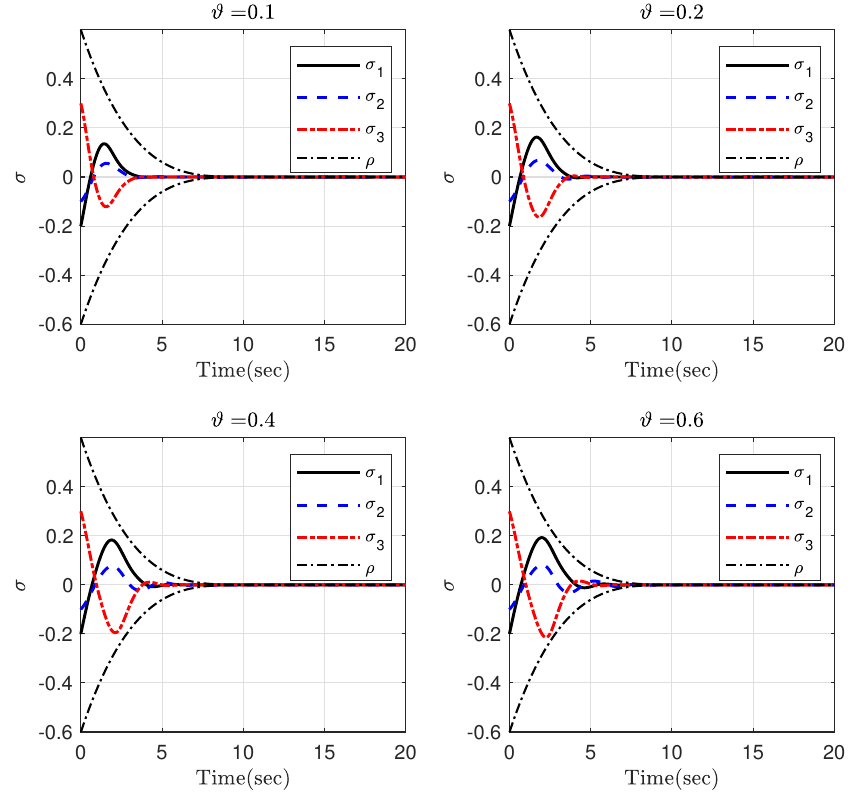
Figure 12. Time responses of the attitude in Part 2 for different ϑ